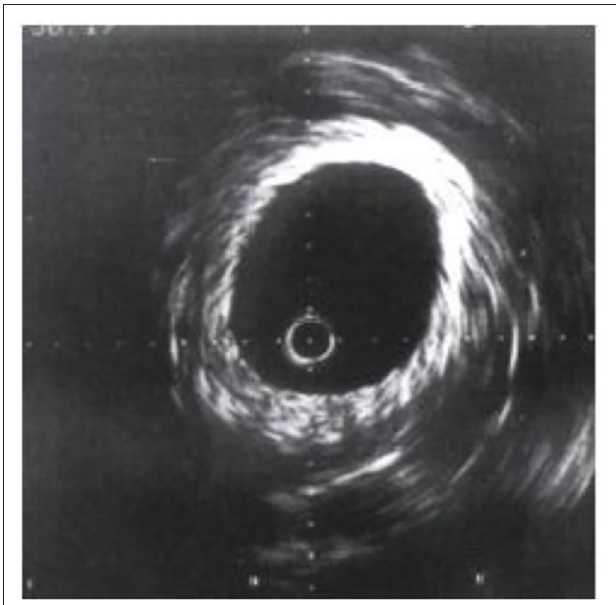
FIGURE 5 | Ultrasound image of non-central